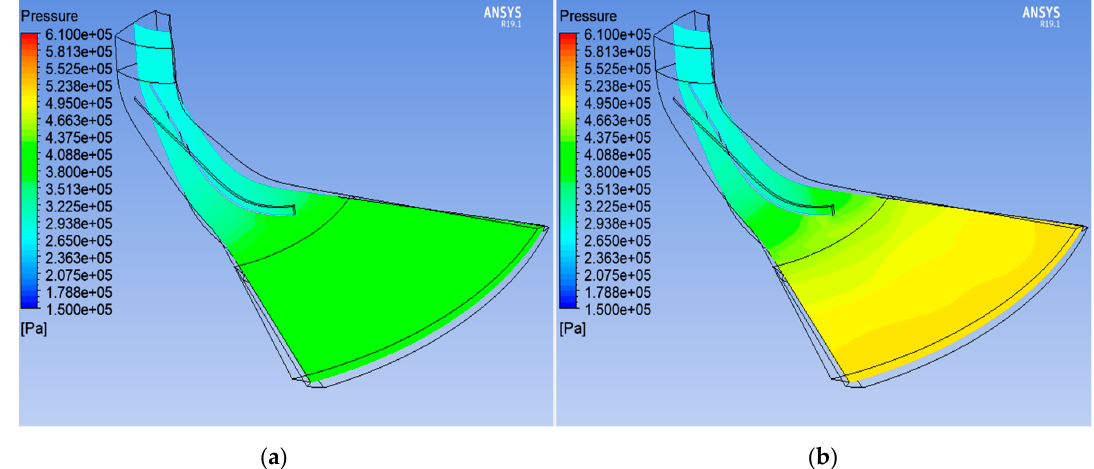
Figure 7. Pressure Contour for R152a at an RPM of 35,000 ( a ) and 40,000 ( b ).